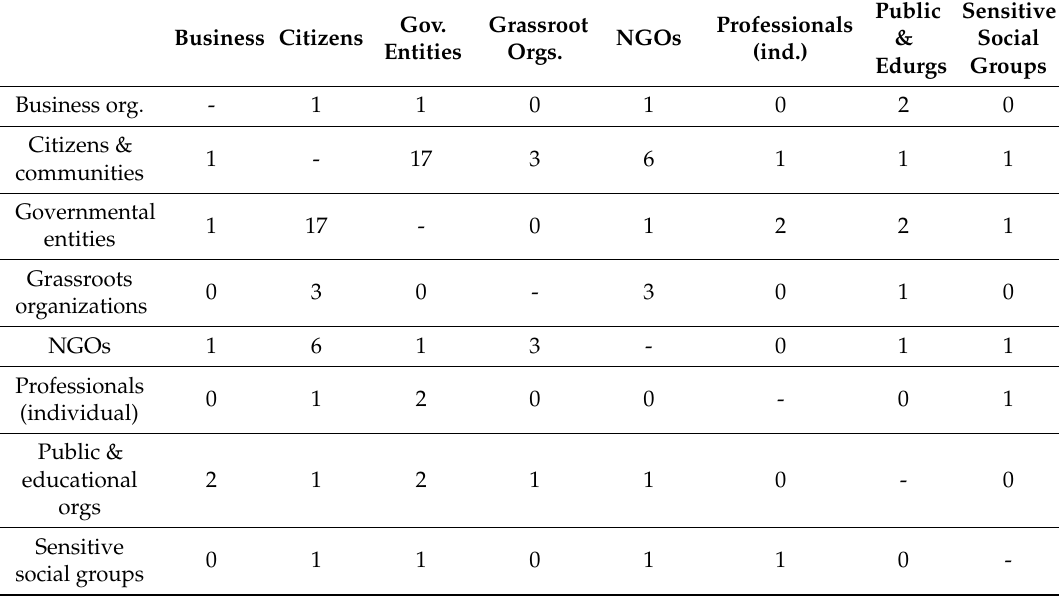
Table 4. The Distribution of Target Groups in the Sample.